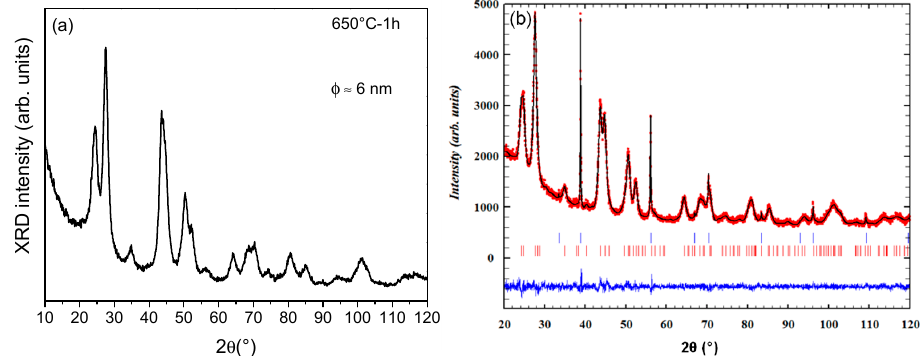
Figure 4. ( a ) X-Ray diffraction (XRD) of 80SiO 2 -20LaF 3 -01Er 3+ (TEOS) self-supported layer treated at 650 ° C for 1 h. ( b ) Observed (small red circles), calculated (continuous black line) and difference (continuous blue line at the bottom) XRD profiles of 80SiO 2 -20LaF 3 -0.5Er 3+ (TEOS-MTES) self-supported layer treated at 550 °C mixed with 9 wt.% NaF as the internal standard. Bragg peaks of NaF and LaF 3 are indicated by blue and red vertical bars, respectively. Table 1. Lattice constants of 80SiO 2 -20LaF 3 -0.5Er 3+ (TEOS-MTES) glass-ceramic bulk sample treated at 550 °C for 1 min.